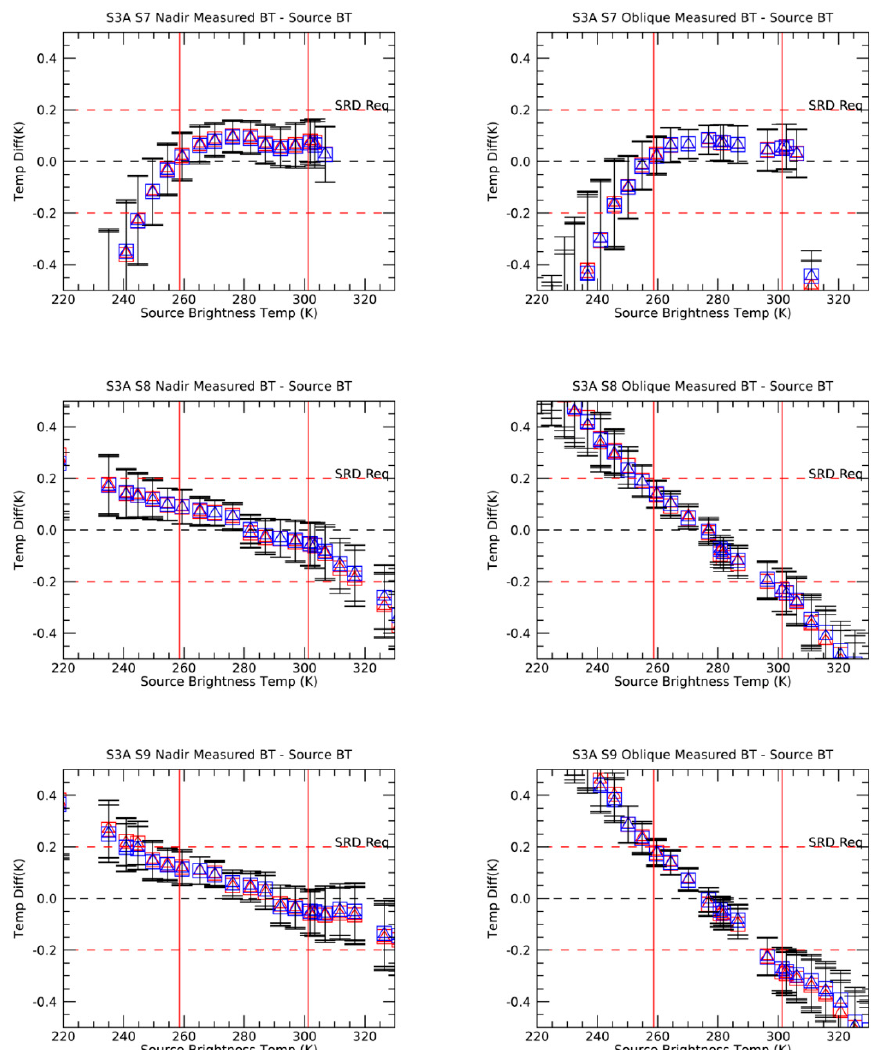
Figure 8. Di ff erences between brightness temperatures of the external BB sources measured by SLSTR-A and the actual BB brightness temperatures. The vertical red-lines correspond to the temperatures of the on-board s. (cid:3) = Detector 1, Integrator 1; (cid:3) = Detector 1, Integrator 2; ∆ = Detector 2, Integrator 1; ∆ = Detector 2, Integrator 2. Error bars represent the combined uncertainty of the measurement at k =